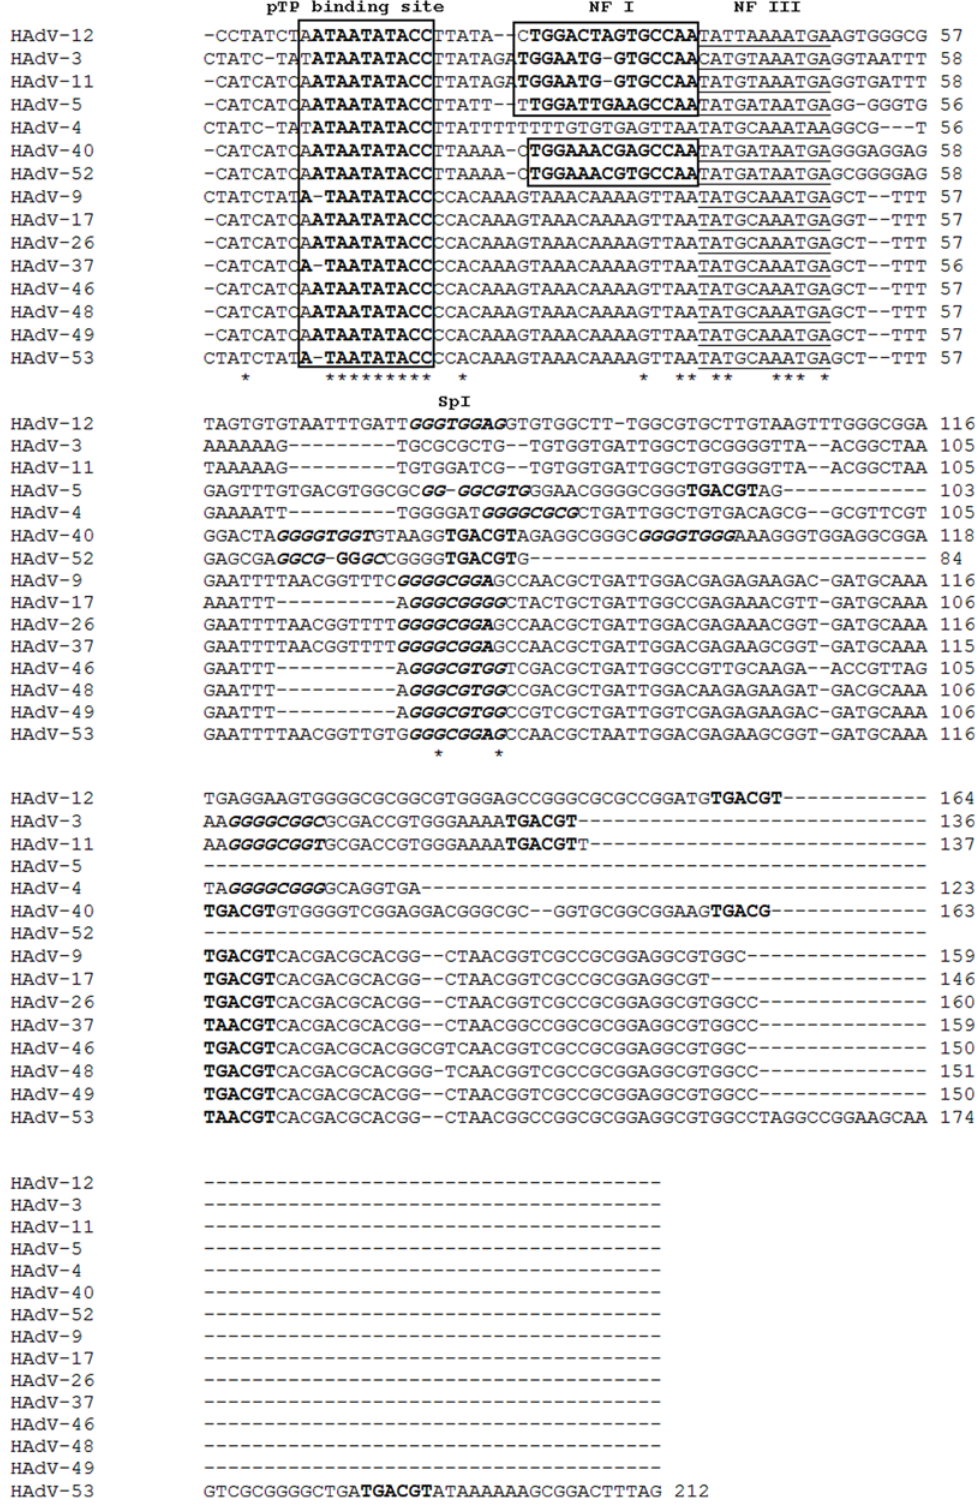
Figure 6. Analysis of the HAdV-D53 inverted terminal repeat (ITR). NF I, NF III, SpI, and pTP binding motifs are marked. The ATF binding site is TGACGT.